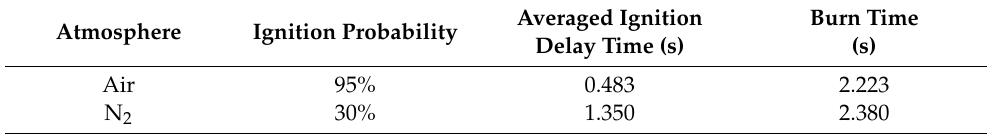
Averaged Ignition Burn Time Delay Time (s) (s)